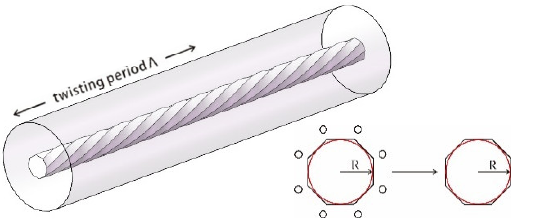
Figure 2. Twisted octagon-shaped core fiber structure. Inset image shows the modification from a P-CCC fiber to a twisted octagon-shaped core fiber (cross section), and the red line is the inscribed circle of the octagonal shape. R is the inscribed circle radius and Λ is the twisting period.